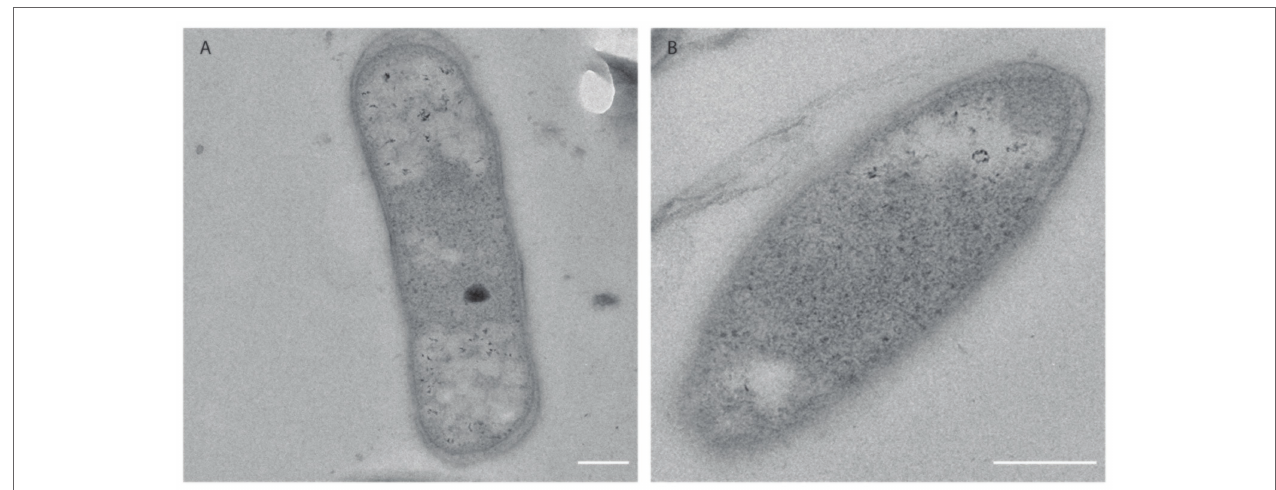
FIGURE 5 | Electron micrograms of M. thermophilum AP8 cells. (A) Rod shaped cells contained ribosomes (black dots), electron-dense particles (black circle), and electron light particles (white particles). Scale bar: 200 nm. Magnification: 20,000×. (B) Cell of M. thermophilum AP8 at higher magnification. Scale bar: 200 nm. Magnification: 40,000×. Membrane stacks and electron dense particles are not